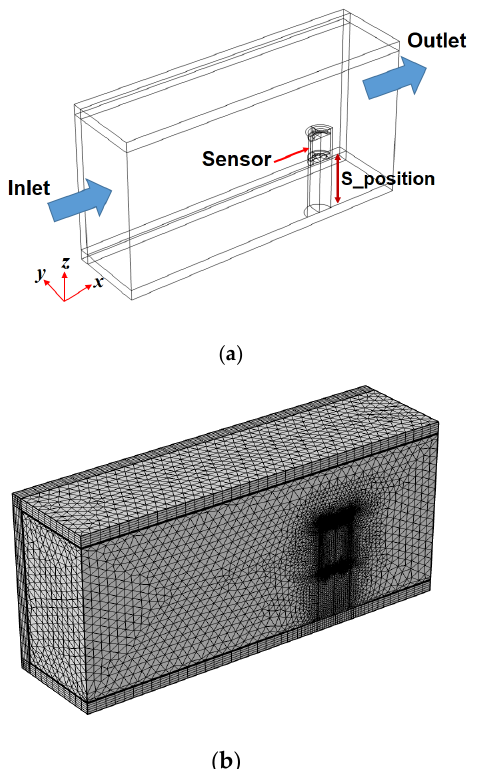
Figure 15. Numerical model used for sensor positioning: ( a ) Control volume; ( b ) Mesh. Table 4. Working conditions for the numerical calculations.